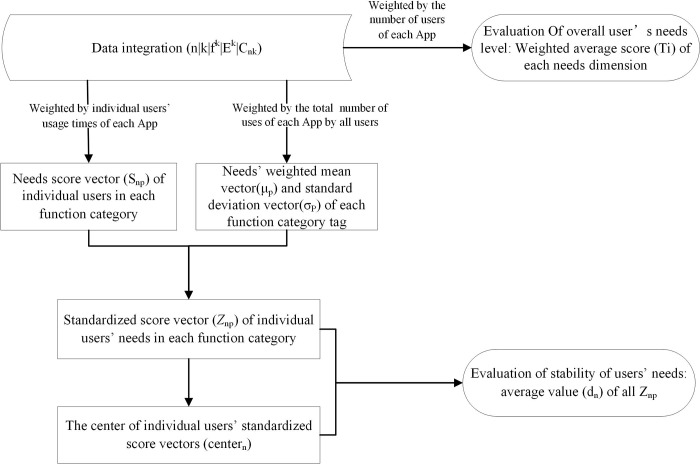
Distribution of the eight types of needs.